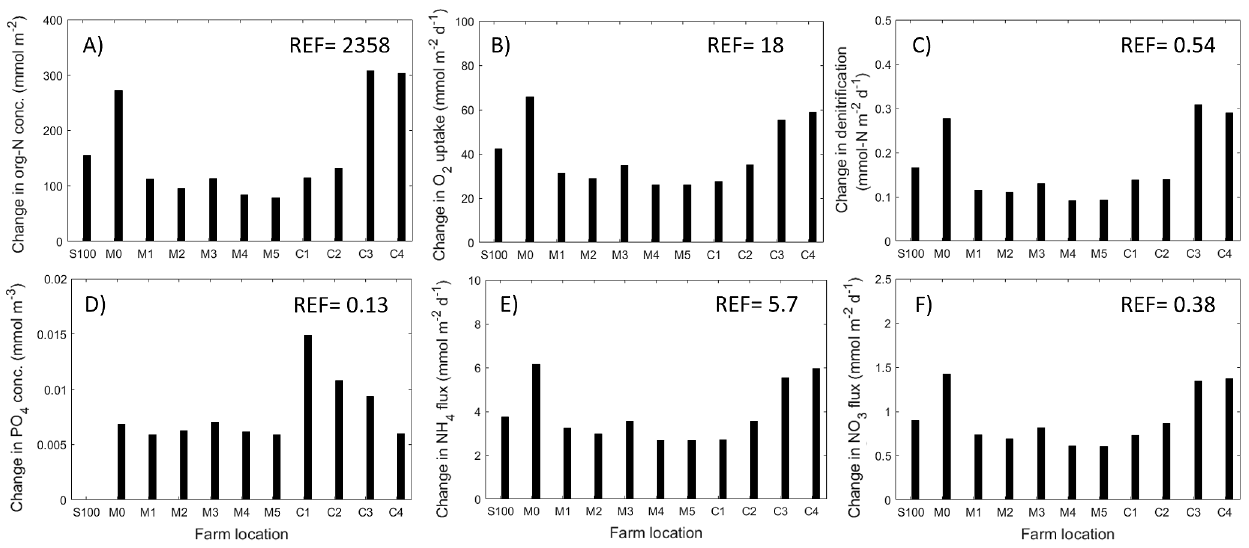
Fig. 9. Benthic impact below the farms. Changes in (A) sediment organic N content, (B) O 2 uptake by the sediment, (C) denitri- fication, (D) PO 4 flux out of the sediment, (E) NH 4 flux out of the sediment and (F) NO 3 flux out of the sediment in the different scenarios relative to the reference scenario (REF) from April to December. The mean values for REF at the fish farm location are shown in the upper right